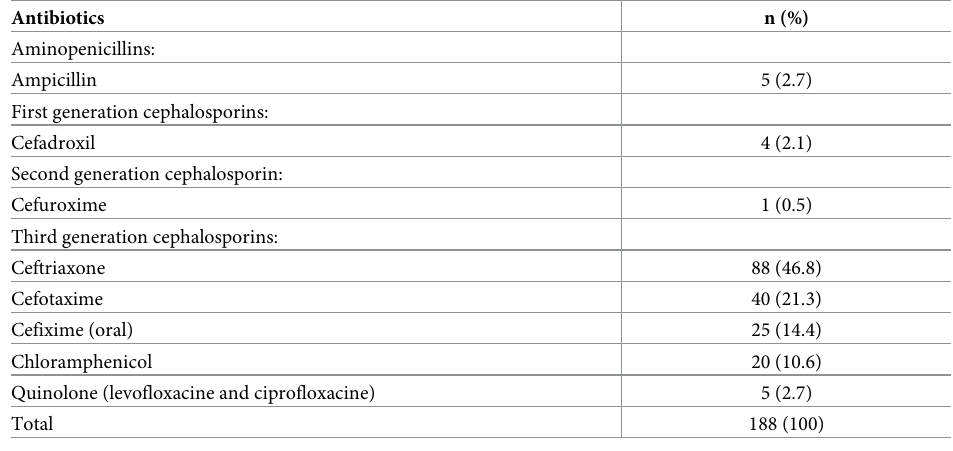
Table 6. Antibiotics used in DVI with concurrent presumed typhoid fever in private